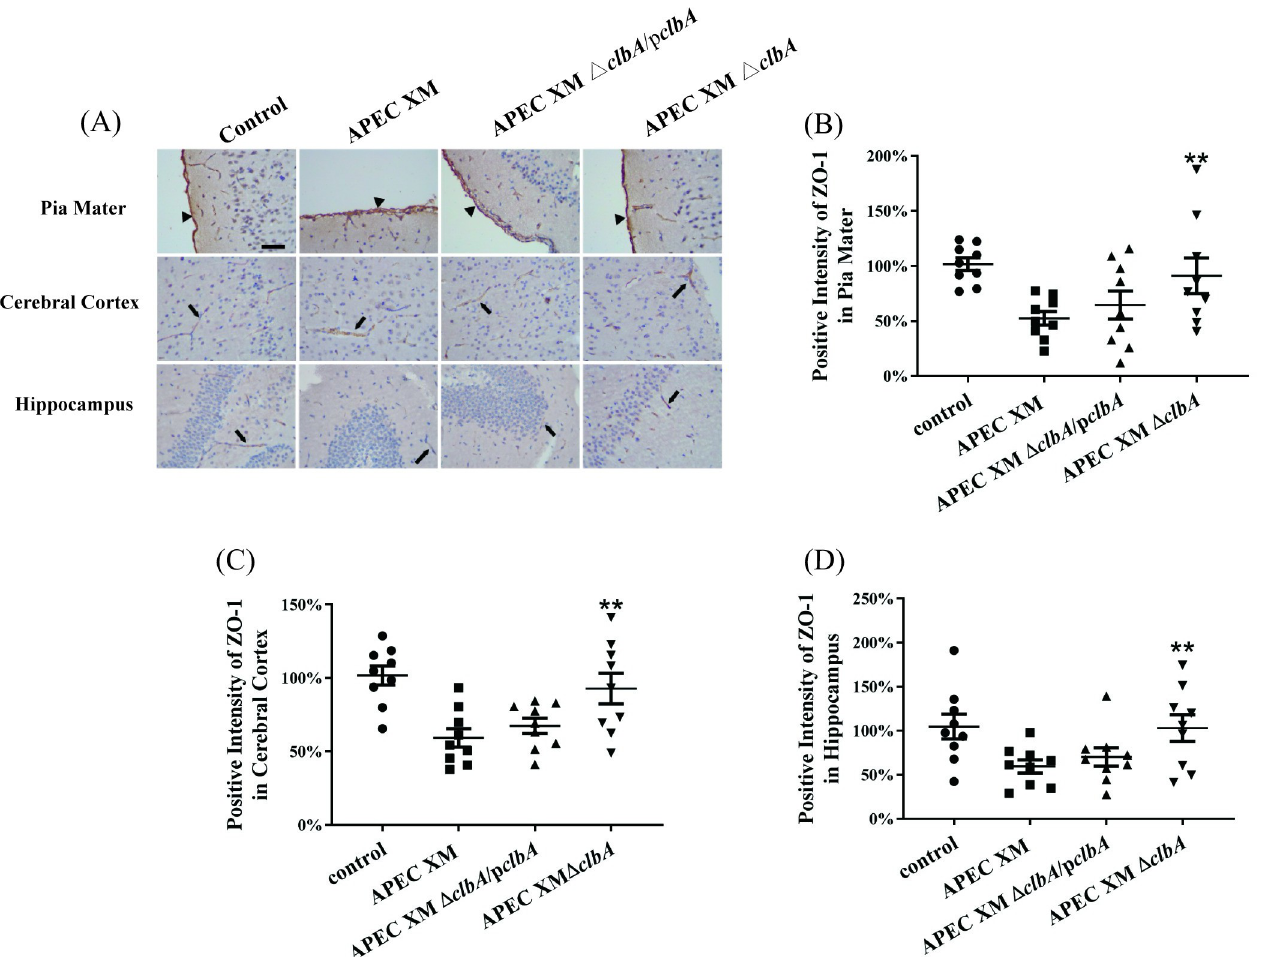
Fig 4. The expressions of ZO-1 in the brain were measured by immunohistochemistry. This experiment was repeated three times. 3 mice were used in each group for each experiment. (A) Immunohistochemistry staining of ZO-1 protein in infected mouse brains (bar = 20 μ m). The black arrowheads point to the pia maters, and the black arrows point to the microvascular. The percentage of positive staining intensity of ZO-1 in pia mater (B), cerebral cortex (C) and hippocampus (D) was calculated by defining the relative optical density of the control group as 100%, and the relative optical densities of other groups were normalized by the control group. The dots represent the relative optical densities for each replicate. Data are analyzed with SPSS 17.0 software using one-way ANOVA. The results are presented as the mean ± standard deviations of three independent experiments. Significant differences between the wild-type strain APEC XM and the APEC XM Δ clbA are indicated ( �� , p < 0.01, versus APEC XM